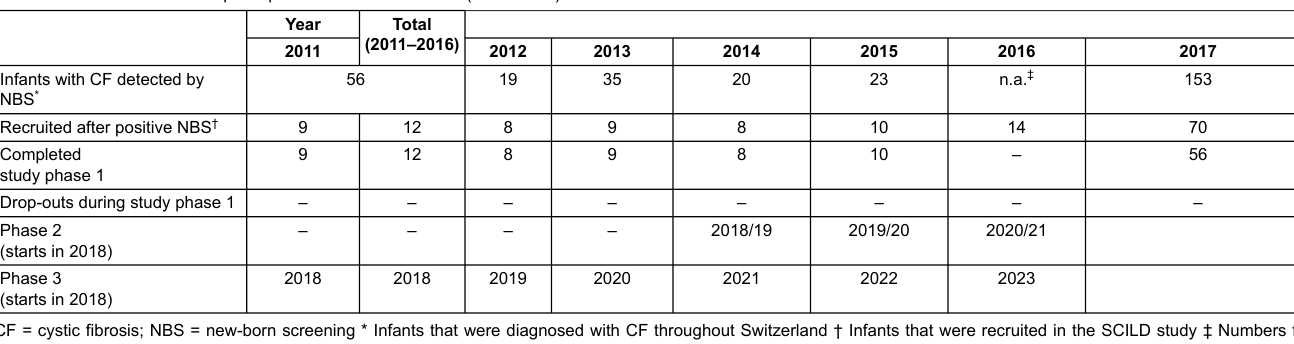
Table 3: Numbers of recruited participants in the SCILD cohort